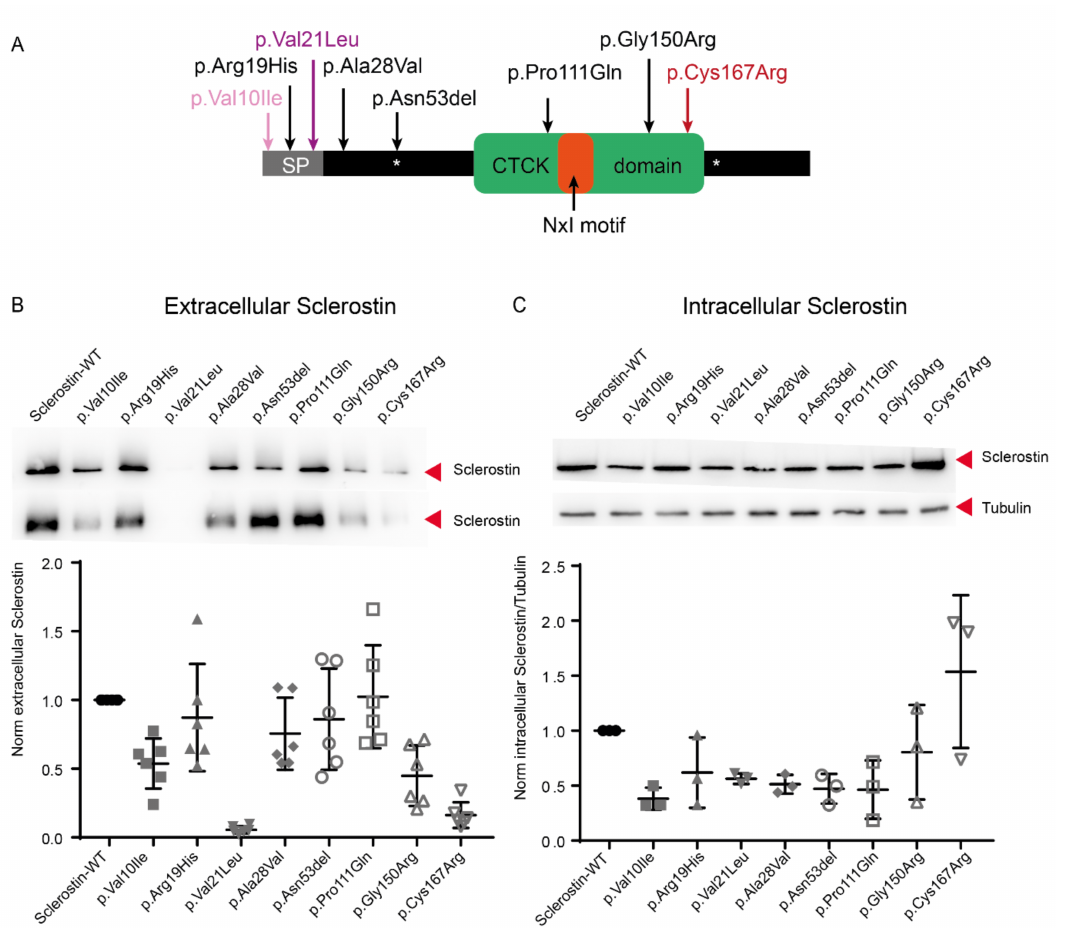
Figure 2. Western blot of variant sclerostin proteins transfected into Saos-2 cells. Variants were generated by in vitro mutagenesis into a SOST expression vector and subsequently transfected and heterologously expressed in Saos-2 cells. ( A ) Tested amino acid variants, displayed along a scheme of the sclerostin, with indication of specific domains (SP: signal peptide; CTCK: C -terminal cystine-knot; NXI:NXI(R/K) sequence motif; asterisks denote the glycosylation N -linked (GlcNAc) asparagine). In red, the mutation present in a patient with sclerosteosis [17]; in purple, the mutation found in a patient with CDD [10] and in pale pink, the mutation associated with high BMD [47] ( B ) Detection of sclerostin in the extracellular media. Above, image of the first biological replicate; below, quantification of the sclerostin bands from images of 6 equivalent blots, normalizing to the extracellular levels of WT sclerostin. ( C ) Detection of intracellular sclerostin. Above, image of the first biological replica of sclerostin and their corresponding tubulin; below, the quantification of the ratios of sclerostin/tubulin protein from images of 3 equivalent blots, normalizing to the ratio of WT